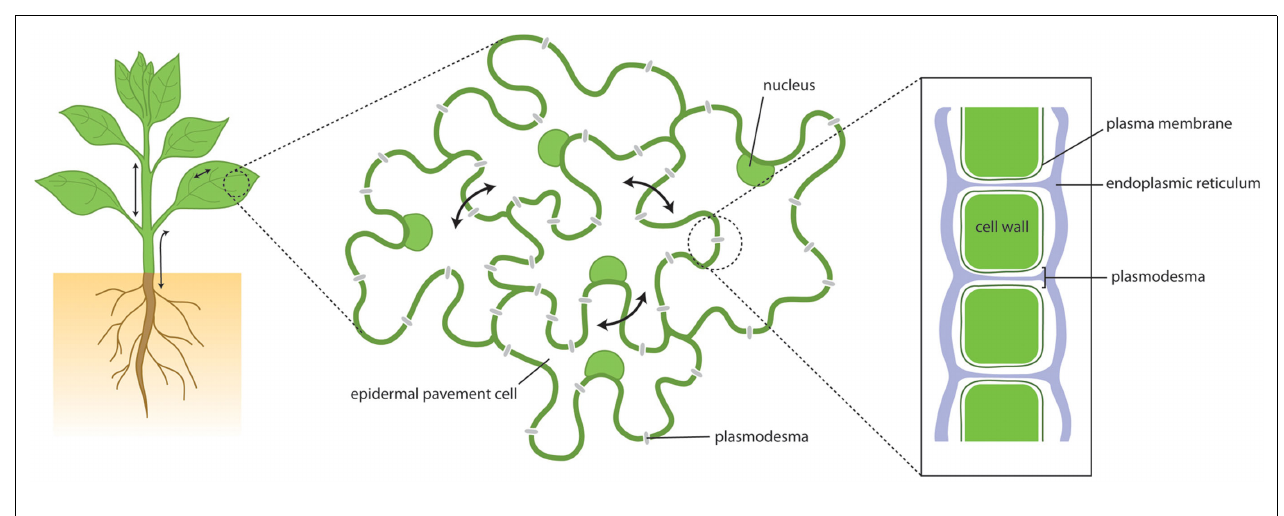
cytoplasmic continuum that is connected through cell walls by plasmodesmata.Through plasmodesmata cytoplasm, plasma membrane and endoplasmic reticulum are all continuous, providing paths for molecular